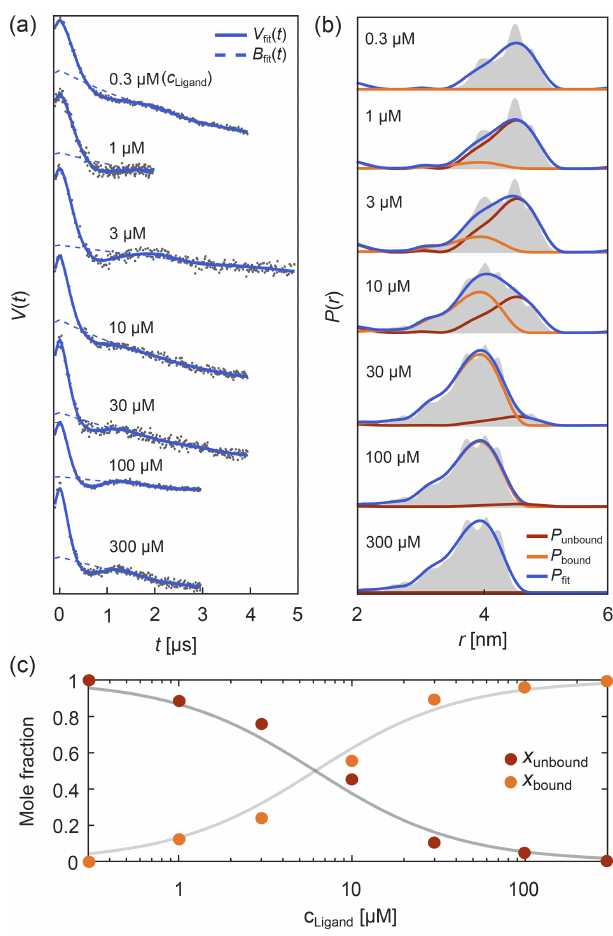
Figure 8. Global fitting of titration data of a protein–ligand bind- ing equilibrium with non-parametric distributions. In panel (a) four- pulse DEER traces with different trace lengths, modulation depths, backgrounds, and noise levels were simulated for different ligand concentrations added to a protein concentration of 1µM. These pa- rameters as well as the mole fractions of bound/unbound protein for each trace and two non-parametric distance distributions for the bound and unbound states (via Tikhonov regularization) were fit simultaneously. The simulated data are given as grey dots and the fitted signals and backgrounds are given as solid and dashed blue lines, respectively. In panel (b) the distance distribution fits for the unbound (red) and bound (orange) states are given as well as the combined fitted distribution (blue) for the different ligand con- centrations. The ground truth sum distributions are given as grey shaded areas. In panel (c) the fitted mole fractions of the unbound (red) and bound (orange) states are given as colored dots. The solid grey lines represent the ground truth for a dissociation constant of K d = 5 .